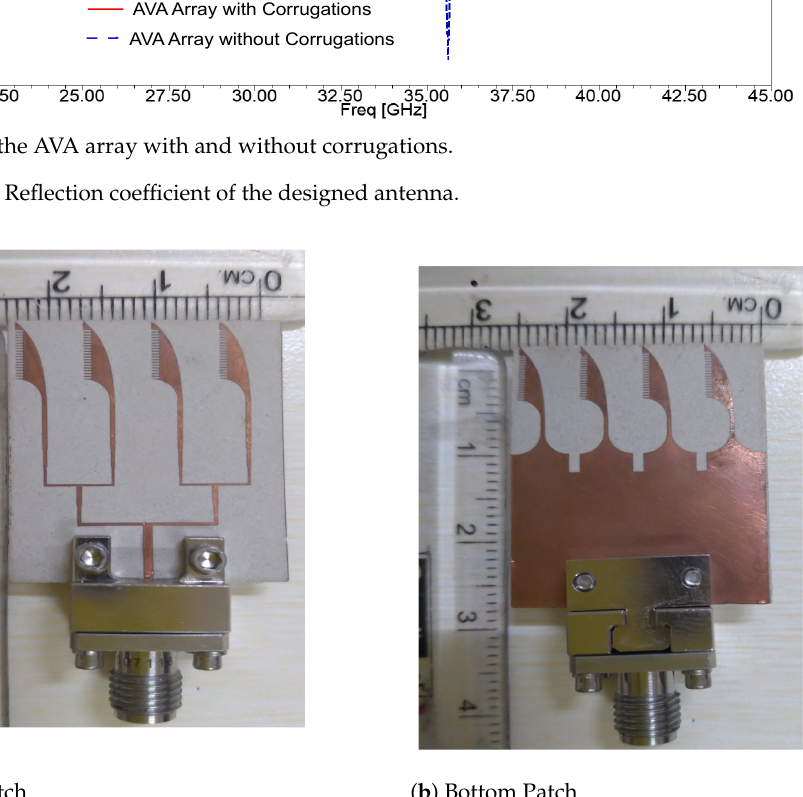
Figure 12. Fabricated proposed